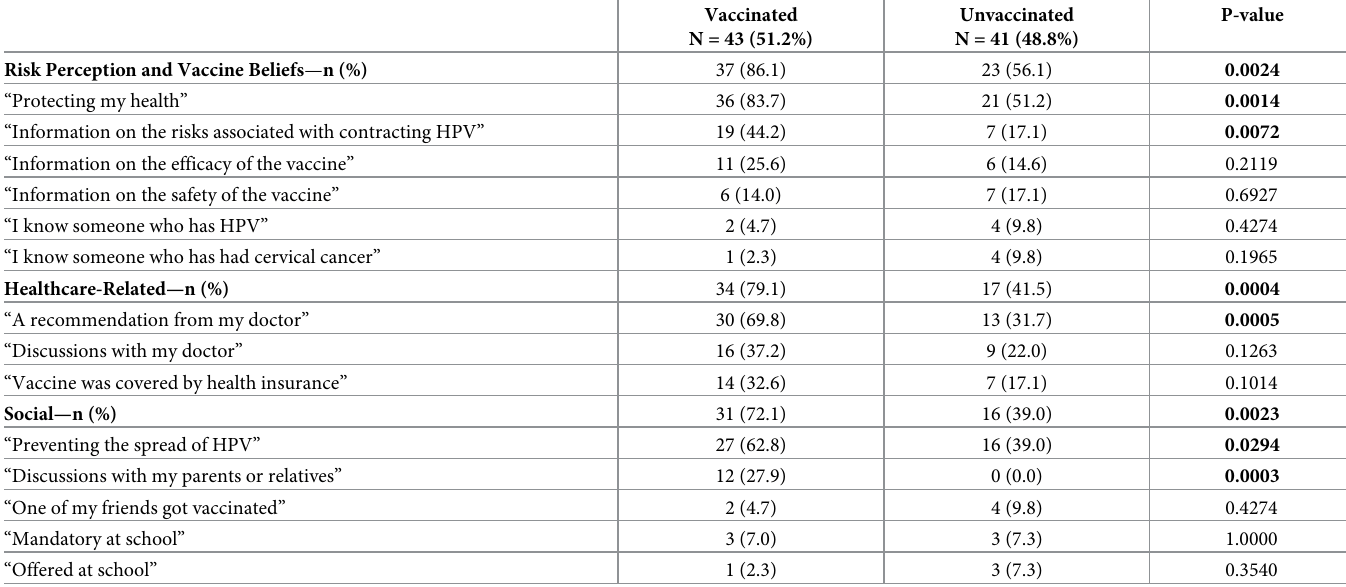
Factors associated with HPV vaccination: Multivariate logistic regressions This model had no violations in multicollinearity (CNI = 10.8) and had good fit (X2 = 8.9, p = 0.349) with no complete or quasi-complete separation issues while using maximum likeli- hood estimates. A one-year increase in age was associated with a 16% lower odds of HPV Table 4. Motivators to HPV vaccination among vaccinate and unvaccinated participants (N =